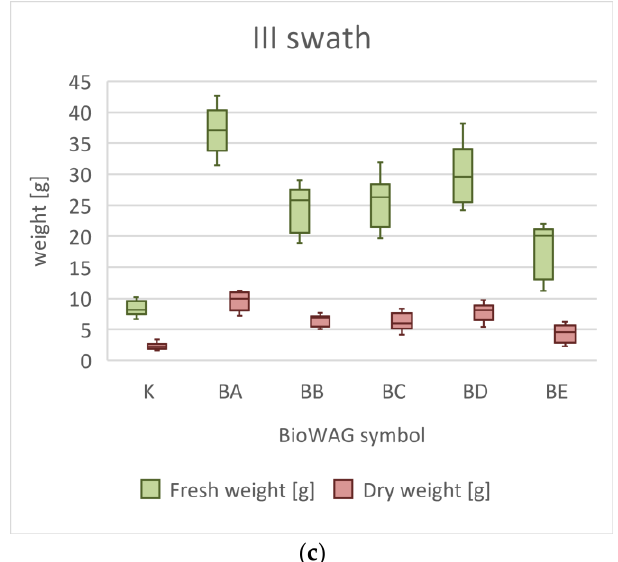
Figure 3. Influence of BioWAGs on the growth of above-ground biomass and dry above-ground mass. ( a ) Growth of fresh and dry grass after the first swath, ( b ) growth of fresh and dry grass after the second swath, and ( c ) growth of fresh and dry grass after the third swath. The diagrams show the first and third quartiles, medians, and minimum and maximum values.